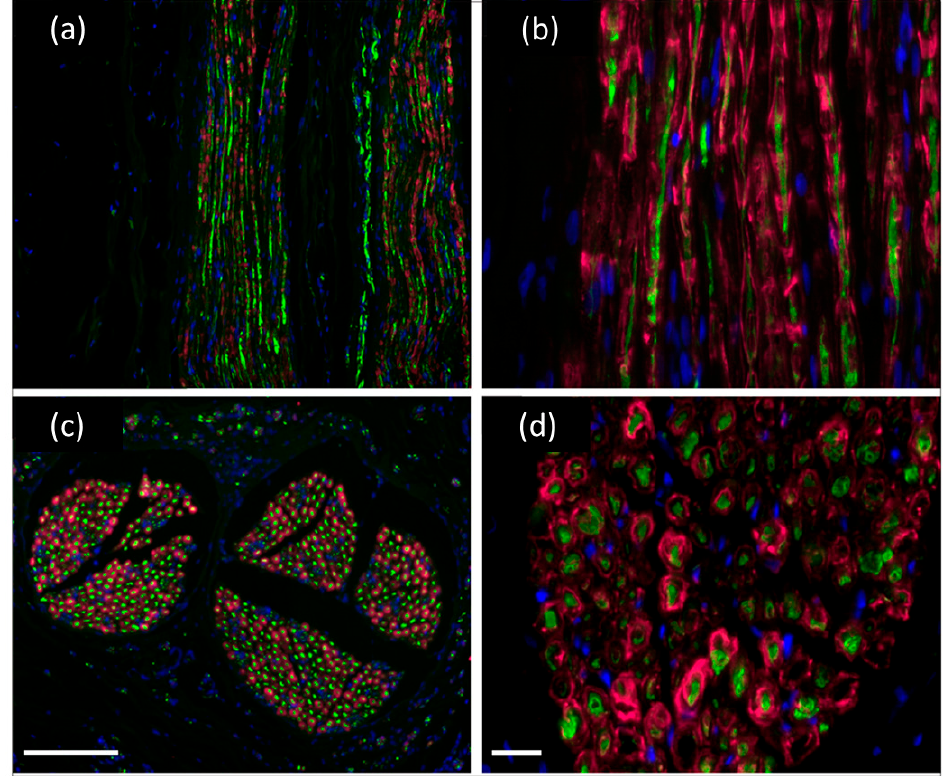
Figure 2. Regenerated nerve fibers following spider silk construct implantation: ( a , b ) Longitudinal section through the construct showing regenerated nerve fibers and Schwann cells in the construct identified with neurofilament (NF, green) and S100 immunostaining (red), respectively, demonstrating that axons regenerated and endogenous Schwann cells migrated within the construct); ( c ) Cross-sections of regenerated nerve after implantation of spider silk construct showed immunopositive staining for S100. Co-association of Schwann cells indicated remyelination of the regenerated nerve fibers in the construct ( c , d ). Nuclear staining with DAPI (blue). Scale bar in ( c ) = 50 µm and pertains to ( a , c ); scale bar in d = 8 µm and pertains to ( b , d ). From Radtke et al., 2011 [48].